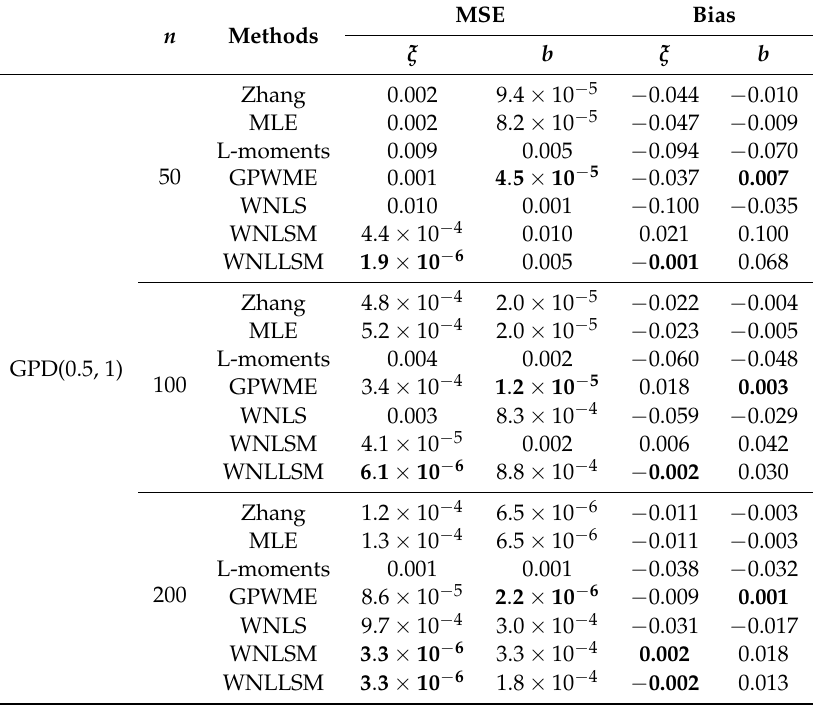
Table 1. Parameter estimation of the generalized Pareto distribution